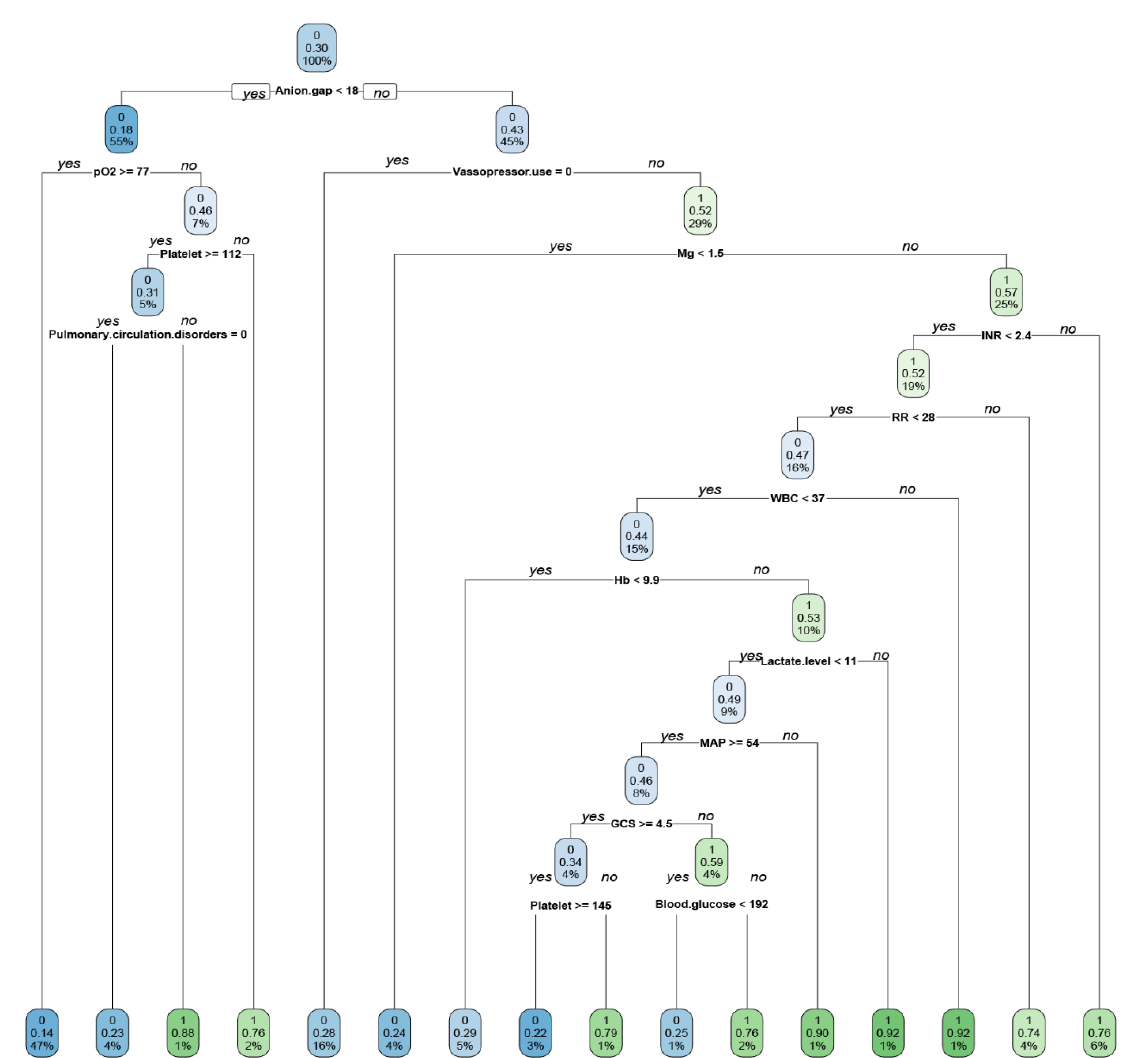
Figure 2. Simple decision tree model showing the classification of ICU patients with lactic acidosis who died (1) and did not (0) die during hospitalization. The numbers with two decimals in each cell mean the probability of mortality in each classification tree. The blue or green color becomes dense when it is more likely to die or not. The % number in the boxes denotes the percentage of patients with each discriminating variable from CART (Classification and Regression Tree) analysis. WBC, White Blood Cell; INR, International Normalized Ratio; RR, Respiratory Rate; MAP, Mean Arterial Pressure; GCS, Glasgow Coma Scale.